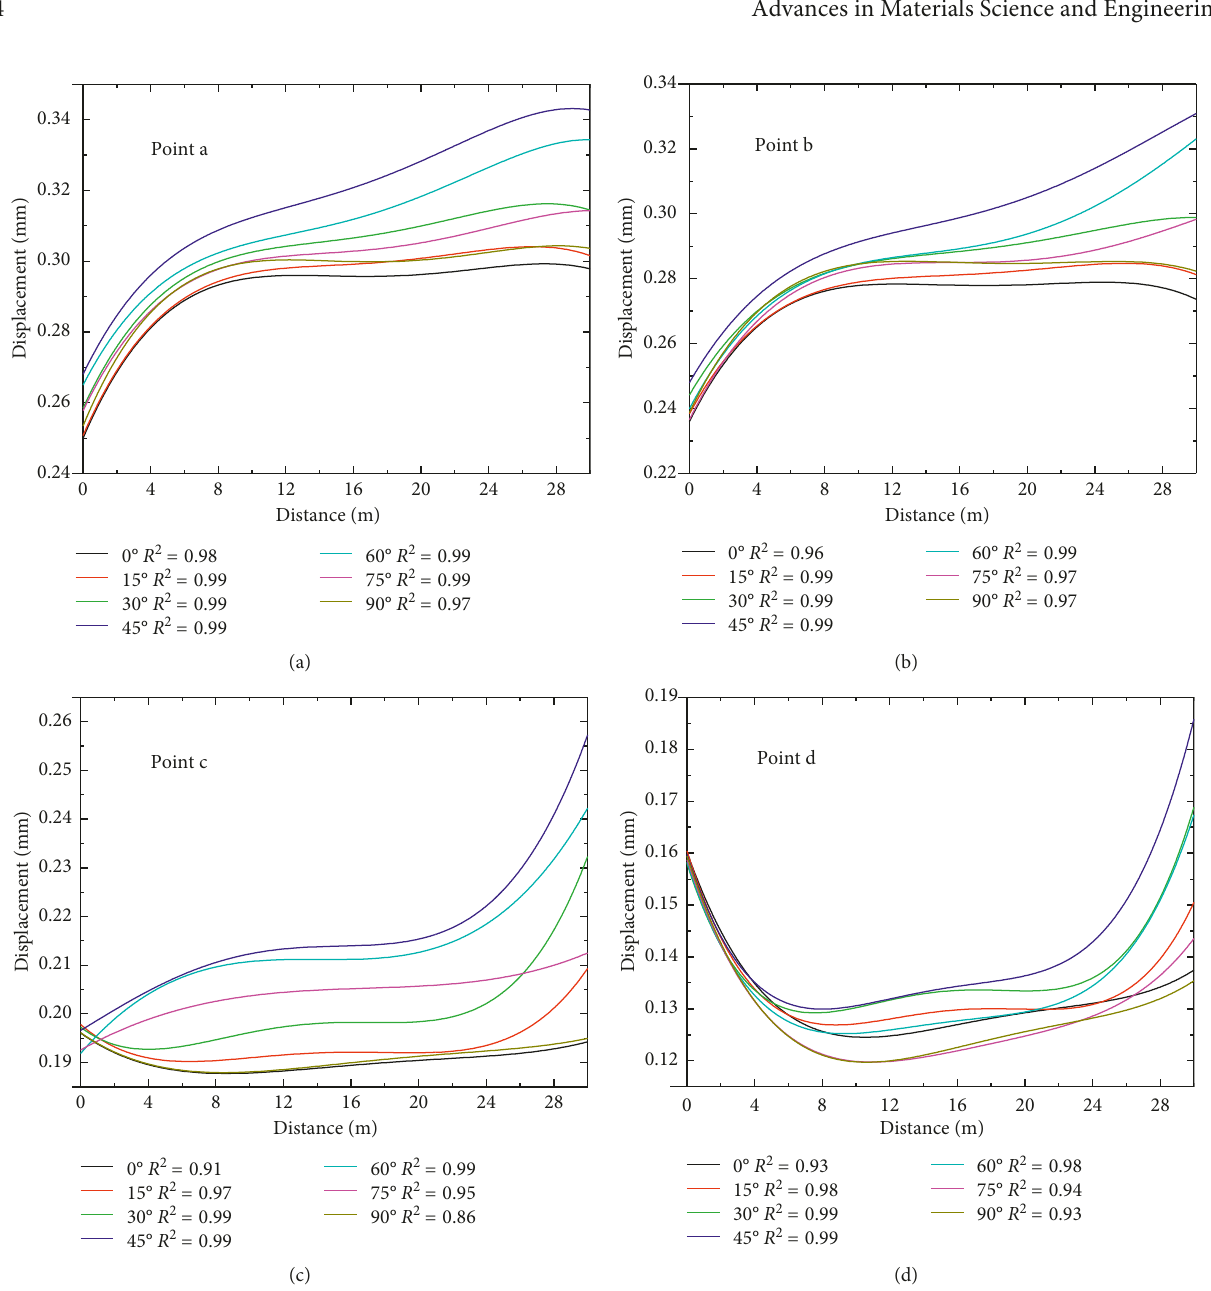
Figure 19: Tunnel displacements variation of point a b, c, and d along the